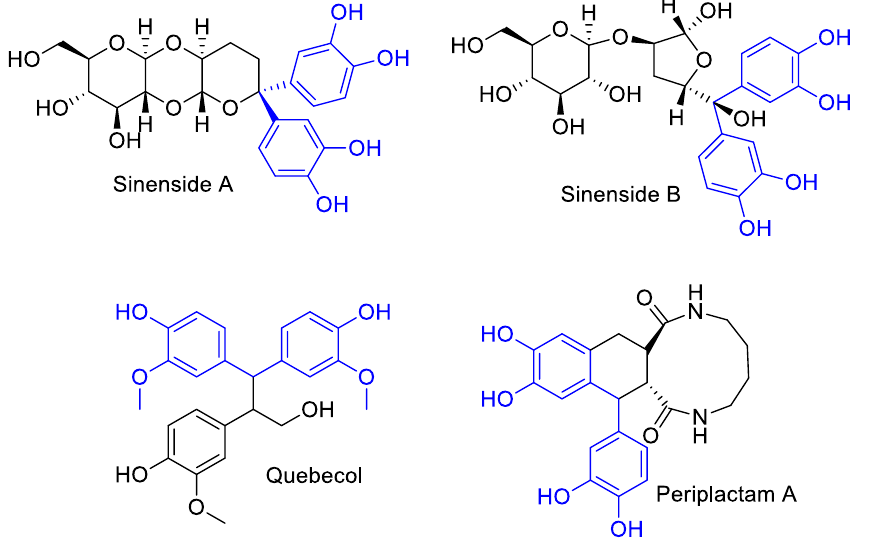
Figure 1. Natural products containing a carbon covalently bound to two catechols.